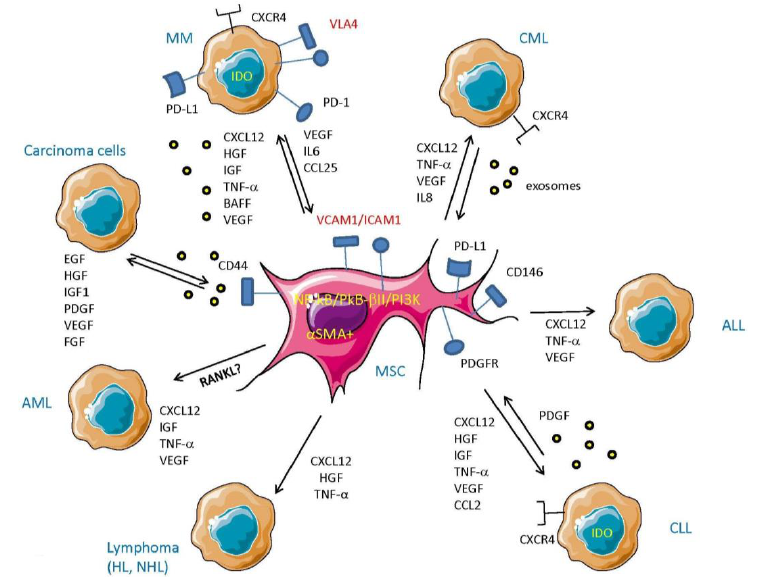
Figure 2. Cross-talk between MSC and tumor cells. MSC mainly through the production of CXCL12 (stromal derived factor-1), which, interacting with CXCR4, can influence the fate of several kinds of leukemic cells by triggering their proliferation, spread, and survival. Also, secretion as soluble or exosome-associated molecules of IL-8, insulin growth factor (IGF), hepatocyte growth factor (HGF), B-cell activating factor of the TNF family (BAFF), TNF-α, and vascular endothelial growth factor (VEGF) markedly influences the survival, expansion, and localization of leukemic and lymphoma cells. Platelet-derived growth factor (PDGF) is an example of the response of leukemic cells to trigger MSC and secrete in turn leukemic cell-sustaining cytokines. Some of the molecules that can be targeted to impair MSC–tumor cell interaction are shown to complete the